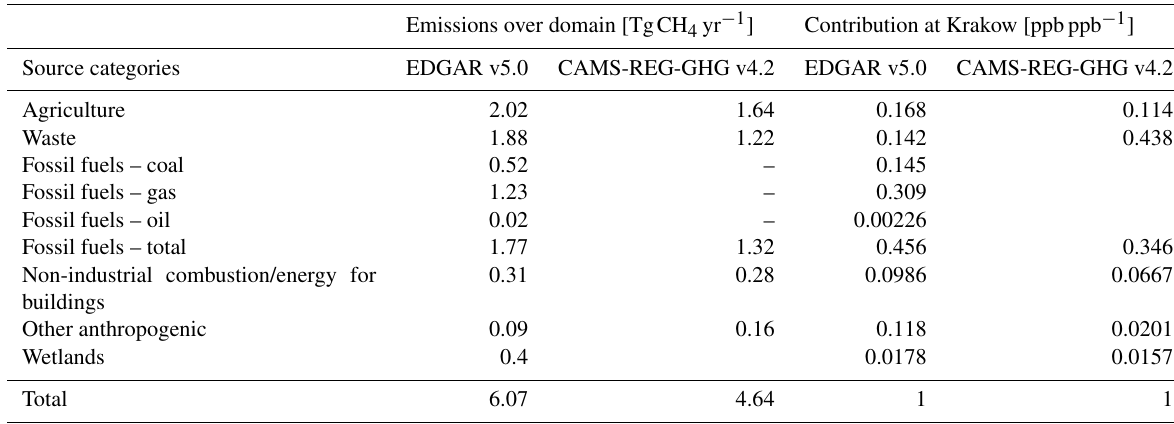
Table 3. Methane absolute emissions and contributions of the different source categories used in CHIMERE to the total simulated χ (CH 4 ), for the EDGAR v5.0 and CAMS-REG-GHG v4.2